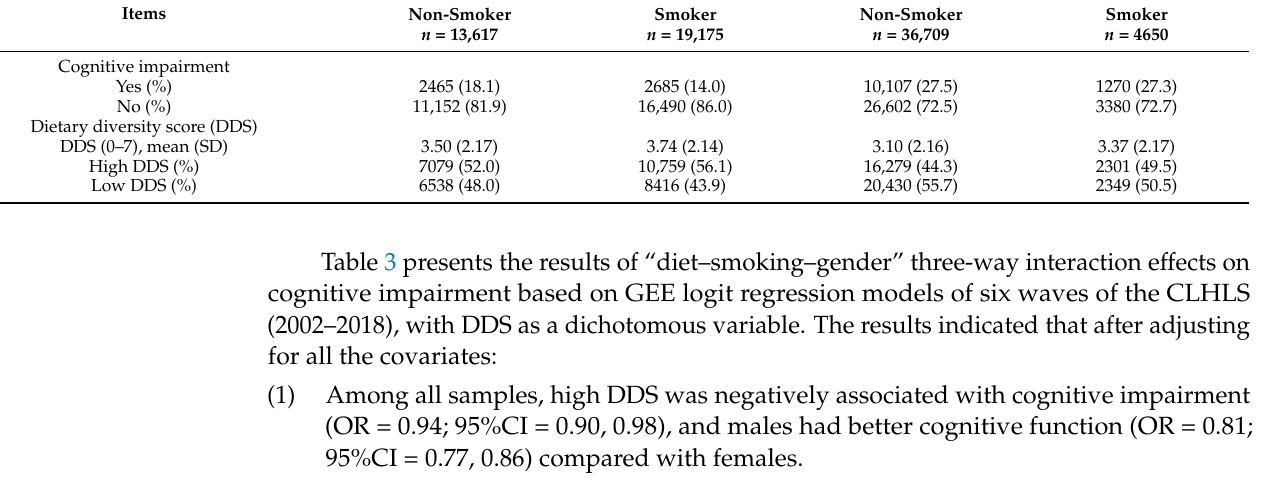
Table 2. Distribution of cognitive impairment and dietary diversity score by gender and smoking behavior, combined by the sex waves of the 2002–2018 CLHLS.